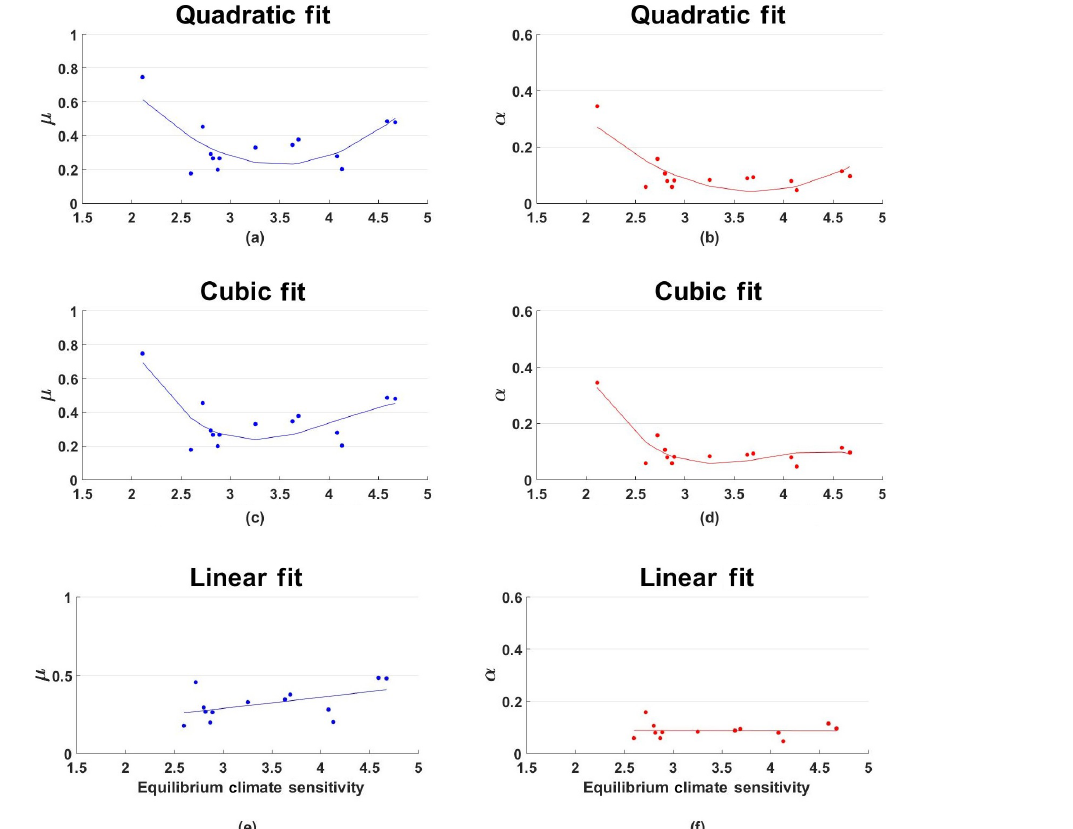
Figure 6. Quadratic (a, b) , cubic (c, d) , and linear (e, f) relationships of µ (a, c, e) and α (b, d, f) in Table 2 to ECS in Table 1. Notice that in the linear case the model GISS_E2_R, as an outlier, is